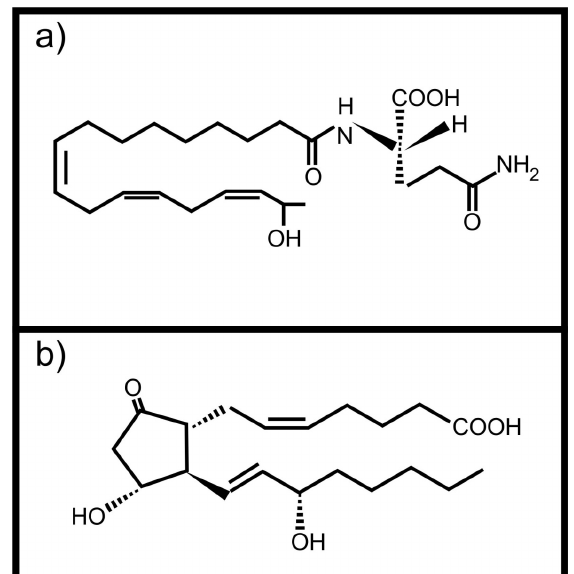
Figure 2. Animal derived oxidized fatty acid signals involved in communication with plants ( a ) Volicitin; ( b ) Prostaglandin E 2